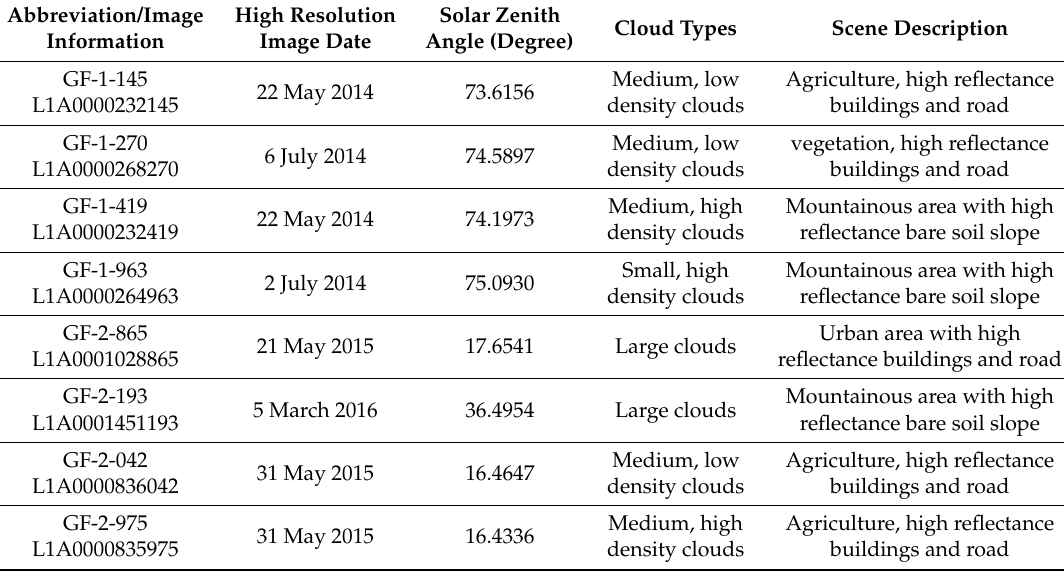
Table 1. Experimental data sources and descriptive information for eight selected